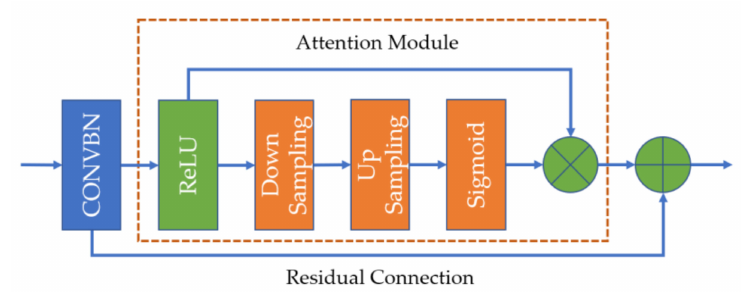
Figure 3. The basic structure of the proposed residual attention